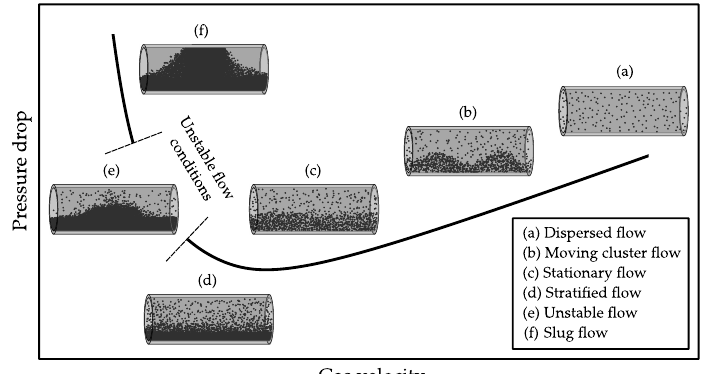
Figure 1. Flow regimes in horizontal pneumatic conveying processes [7].